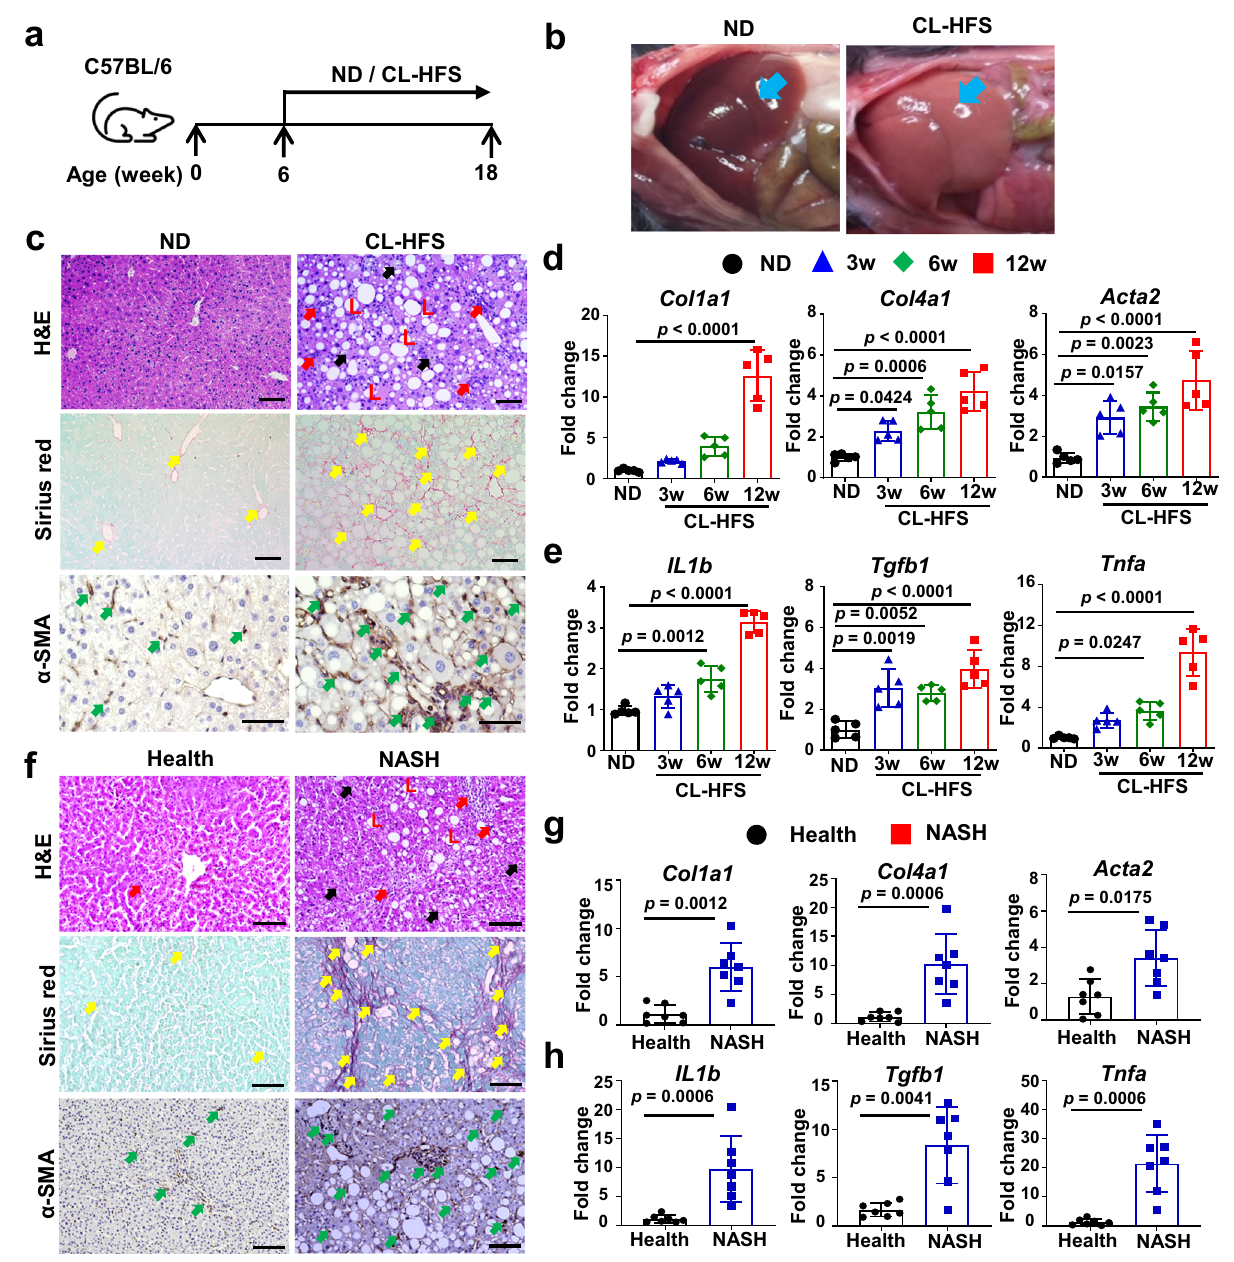
Fig.1|EstablishmentandcharacterizationofamouseNASHmodel.a Anoutline depicting induction of NASH with a CL-HFS. Six-week-old WT C57BL/6J mice were fed a CL-HFS or normal diet (ND) for 12 weeks. At week 18, each mouse was euthanized for the following studies. b Representative macroscopic images of